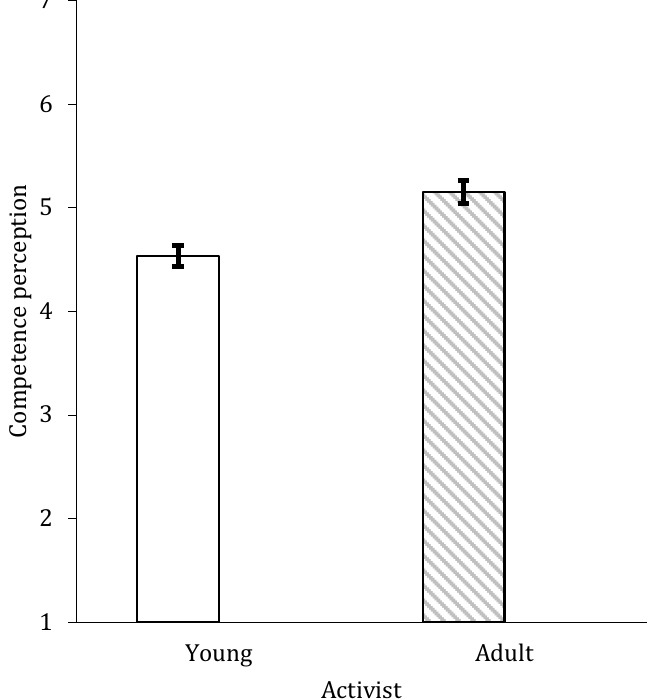
Figure 2. Means and standard errors regarding competence by experimental conditions.